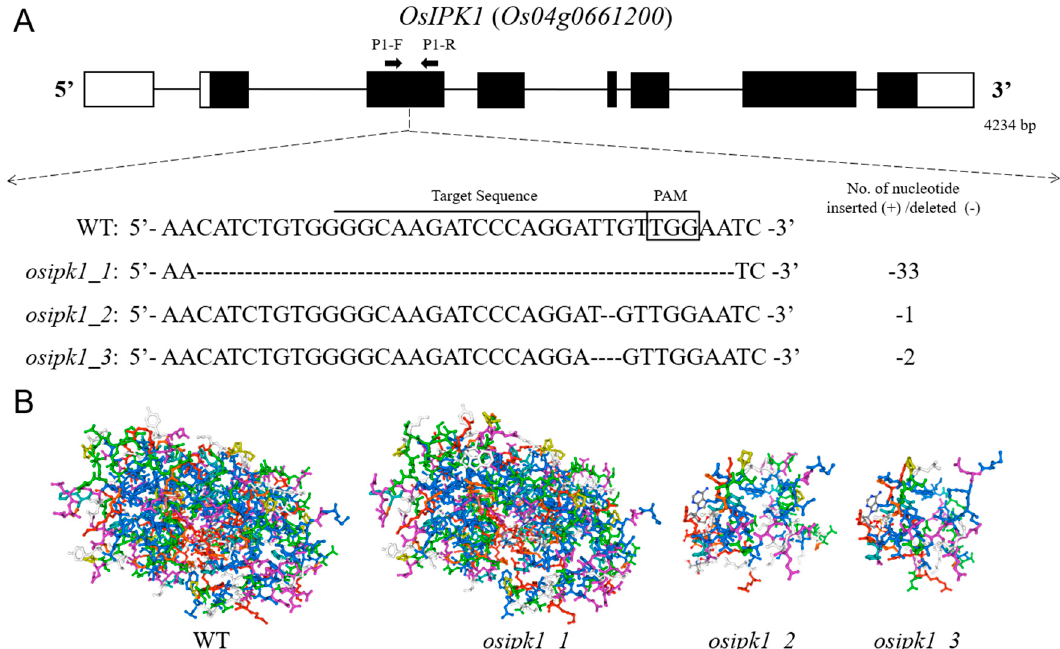
Figure 1. Schematic diagram of OsIPK1 and the sgRNA target site for its clustered regularly interspaced short palindromic repeats (CRISPR) and CRISPR-associated protein (CRISPR/Cas9)-mediated mutagenesis ( A ), and prediction of IPK1 proteins in Xidao #1 (WT) and its osipk1 mutants ( B ). Exons, introns and untranslated regions (UTRs) are indicated by solid boxes, lines and blank boxes, respectively. P1-F and P1-R are primers for genotyping osipk1 mutations, with their position indicated by arrowheads. The protospacer adjacent motif (PAM) sequences (NGG) are boxed and the 20-nt target sequences are underlined. ‘–’ indicates deletion of nucleotide. The 3-dimensional structures of WT and mutant osipk1 were analyzed on SWISS-MODEL (https://www.swissmodel.expasy.org/).